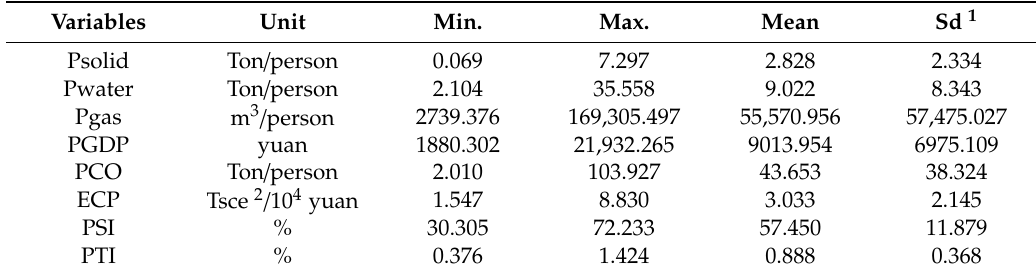
Table 1. A detailed description of the